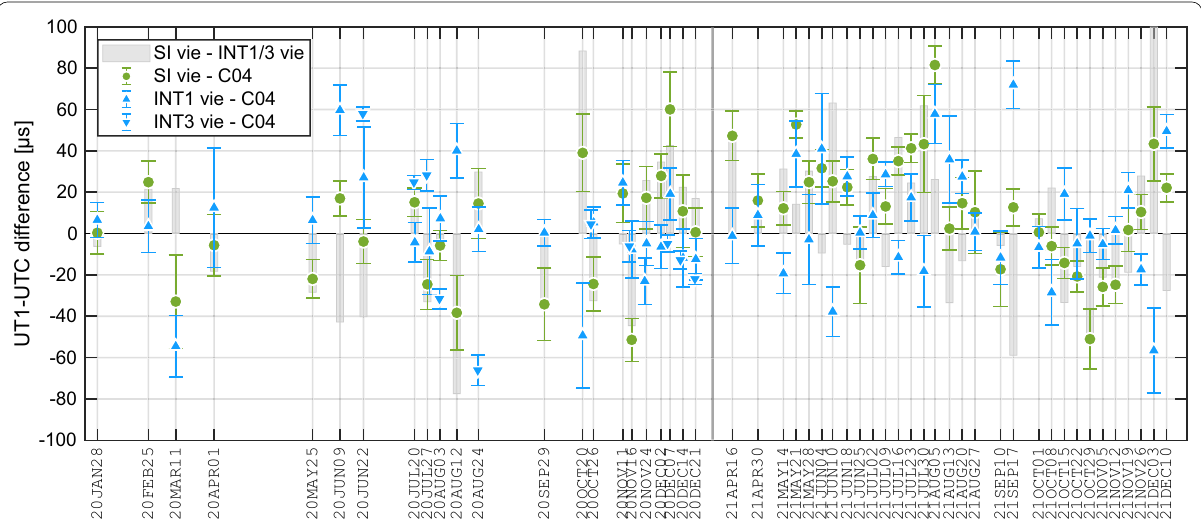
Fig. 6 Differences between SI vie and INT1/3 vie UT1 UTC results and with respect to IERS 14C04 (C04) in µs. The differences SI vie minus INT1/3 − vie are printed as grey bars. The error bars show the formal errors of the Intensive sessions. Green circles illustrate SI vie minus C04 results, blue upward/downward pointing triangles INT1/3 vie minus C04 values. The labels on the horizontal axis are the dates of the SI